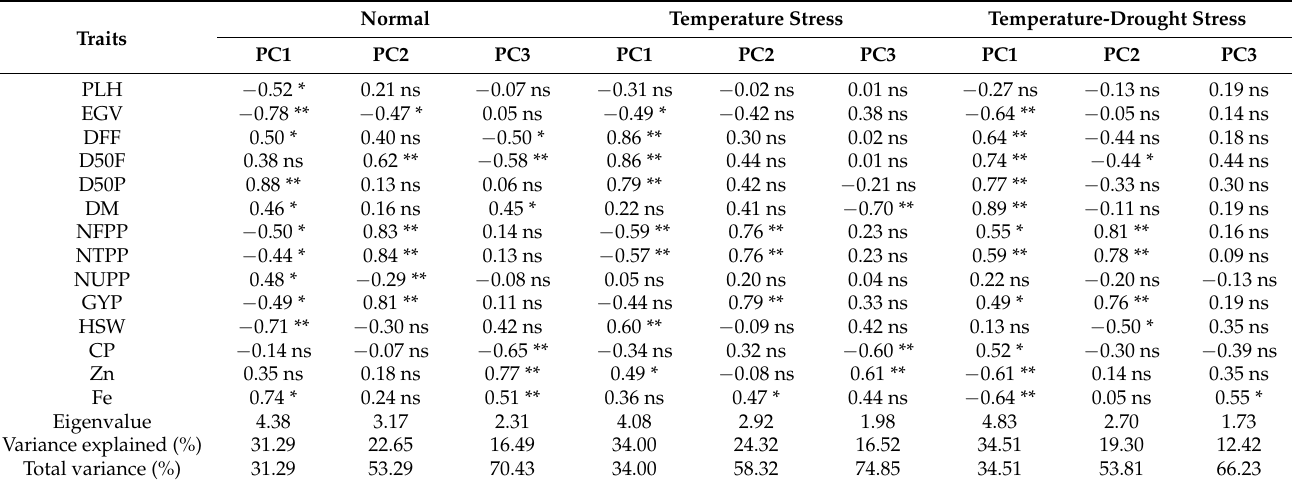
Table 2. Eigenvalues and eigenvectors of the three PCA dimensions under normal conditions, temperature stress and the combined temperature-drought